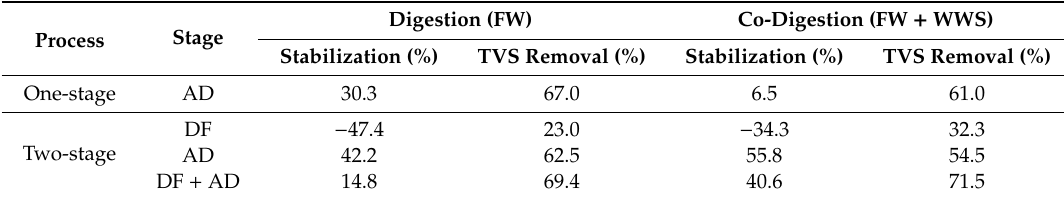
Table 4. Process e ffi ciency expressed in terms of biological stabilization and total volatile solids (TVS)